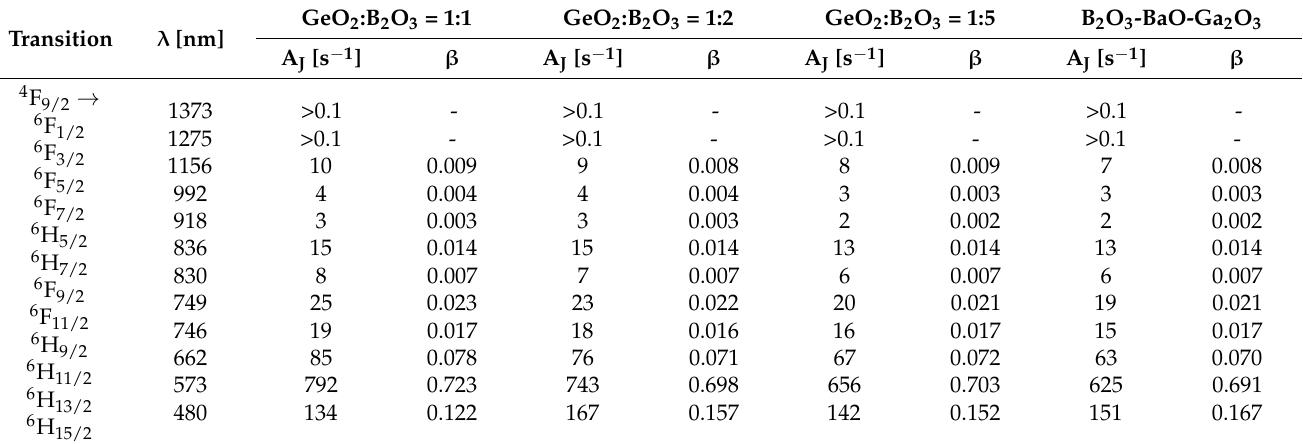
Table 7. The radiative transition probabilities and luminescence branching ratios for Dy 3+ ions